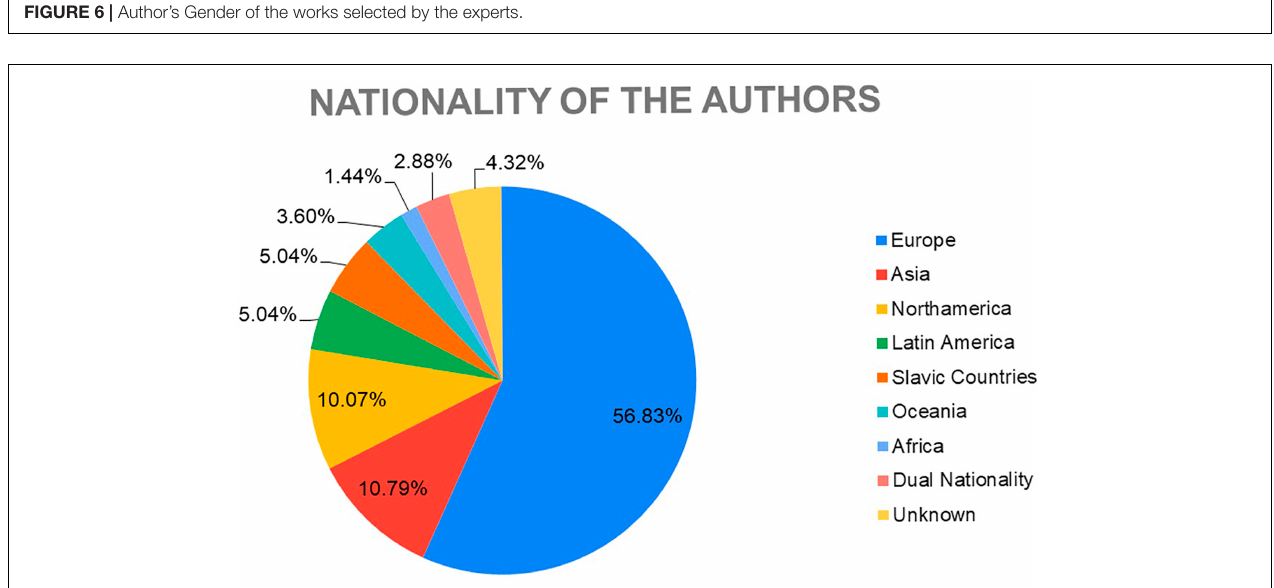
FIGURE 7 | Author’s nationality of the works selected by the experts.